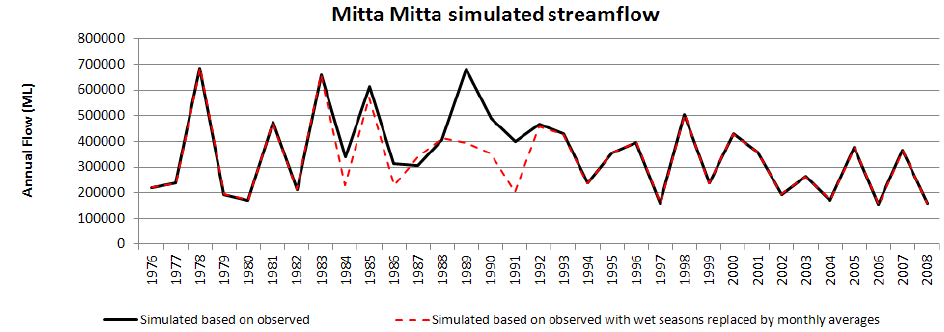
Figure 19. Monthly simulated streamflow for Mitta Mitta Creek located in Victoria,